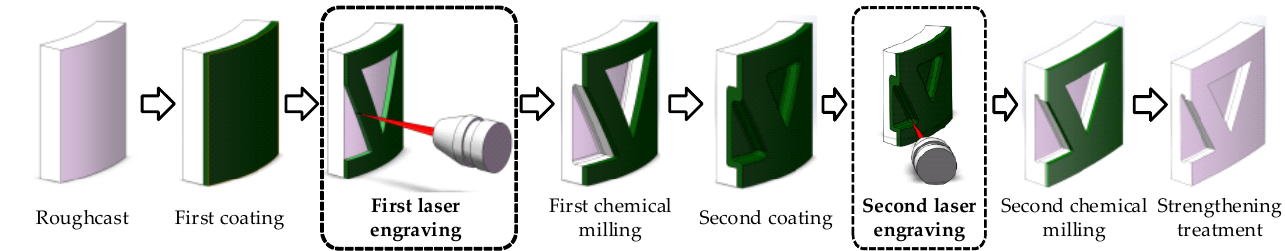
Figure 1. Chemical milling processing diagram of an aero-engine casing body.